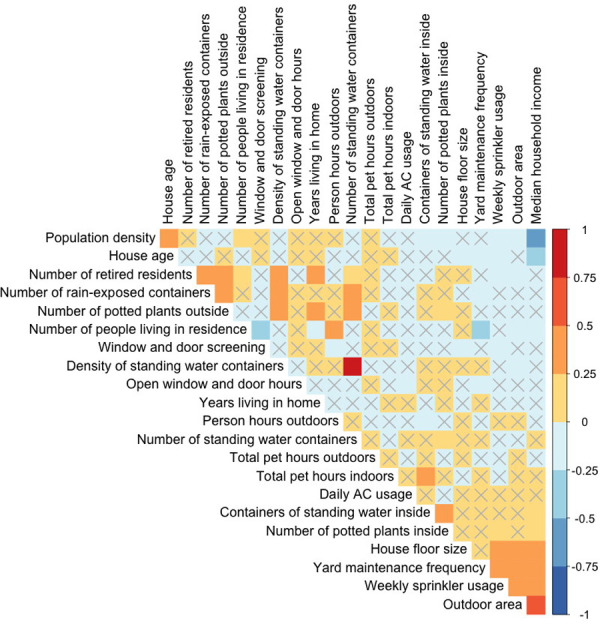
Correlations between all household and census-tract-level continuous variables among households in Los Angeles County.Colors represent the magnitude and direction of the Pearson’s correlation coefficient, respectively. Boxes without an ‘X’ indicate significantly correlated variables (P < 0.05).